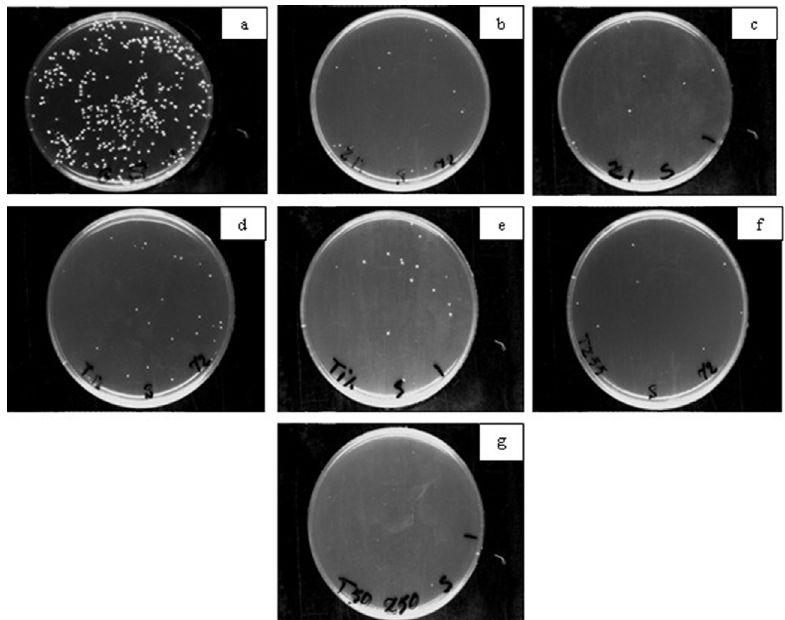
Fig. 8. S. aureus colonies in direct treatments with LDPE films loaded by any NPLs in control sample (a), 1% ZnO NPLs under fluorescent light (b), 1% ZnO NPLs under UV light (c), 1% TiO 2 NPLs under fluorescent light (d), 1% TiO 2 NPLs under UV light (e), 1% mixed of 50-50 TiO 2 and ZnO NPLs under fluorescent light (f), 1% mixed of 50-50 TiO 2 and ZnO NPLs under UV light